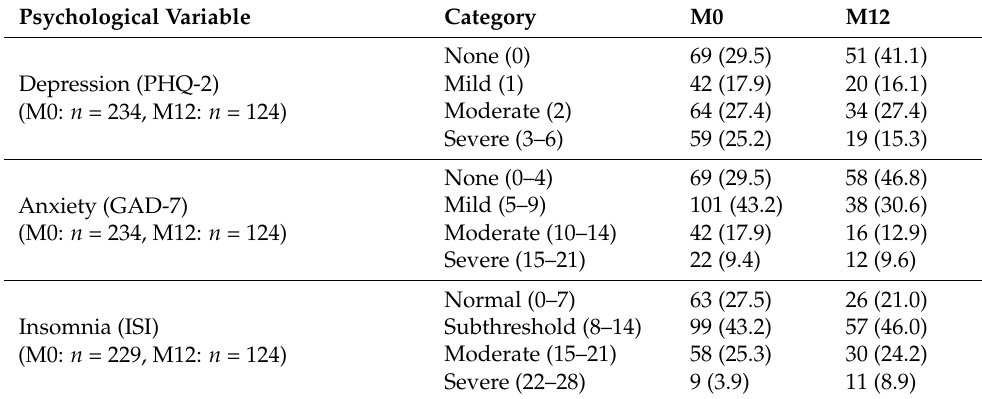
Table 5. Psychological factors at M0 and M12: depression (PHQ-2), anxiety (GAD-7), insomnia (ISI). Psychological